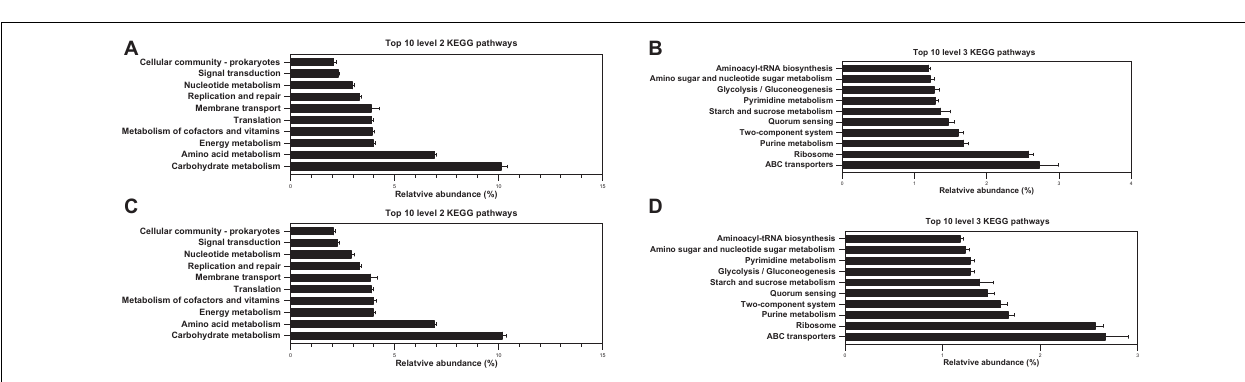
FIGURE 8 | Effects of different diets on predicted metagenomic functions of the KEGG pathway in weaned piglets. (A,B) Top 10 predicted metagenomic functions at level 2 (A) and level 3 (B) of the KEGG pathways in colon. (C,D) Top 10 predicted metagenomic functions at level 2 (C) and level 3 (D) of the KEGG pathways in